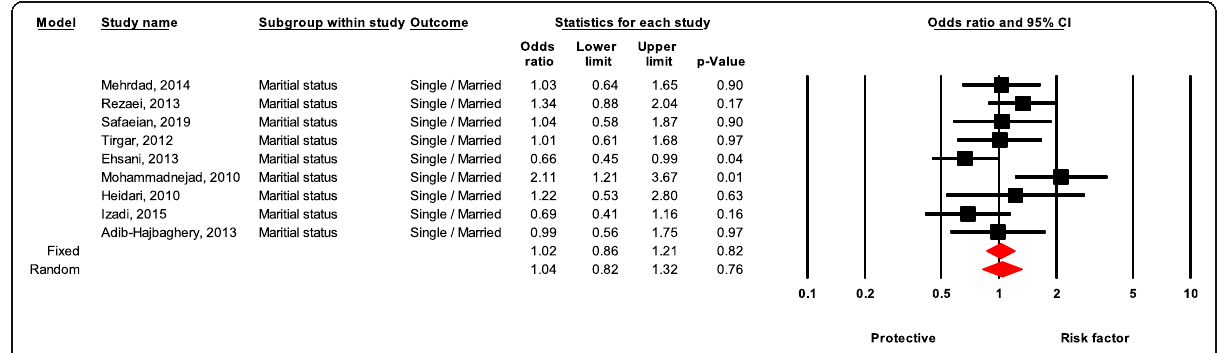
Fig. 7 Forest plot for relationship between marital status and risk of NSI in